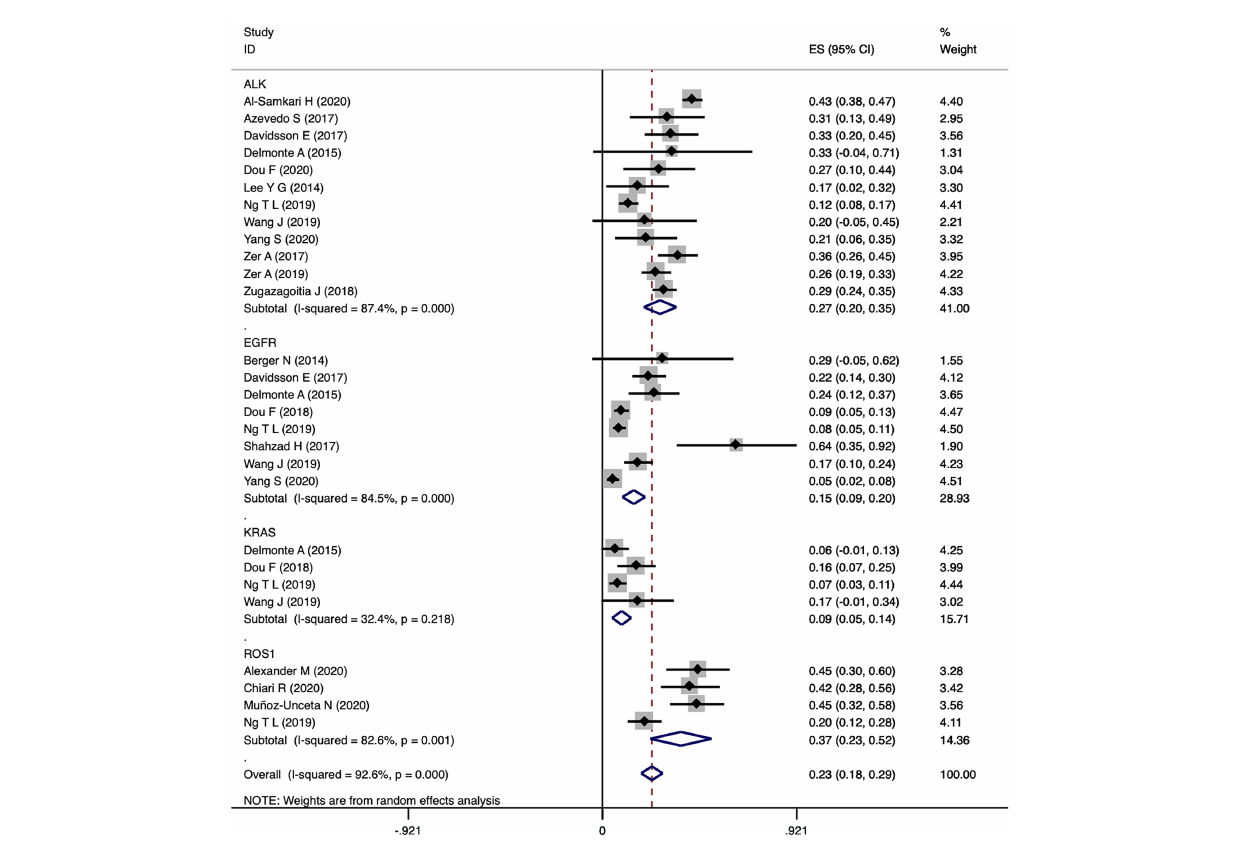
FIGURE 2 | Pooled estimates for incidence of VTE in patients with 4 driver gene